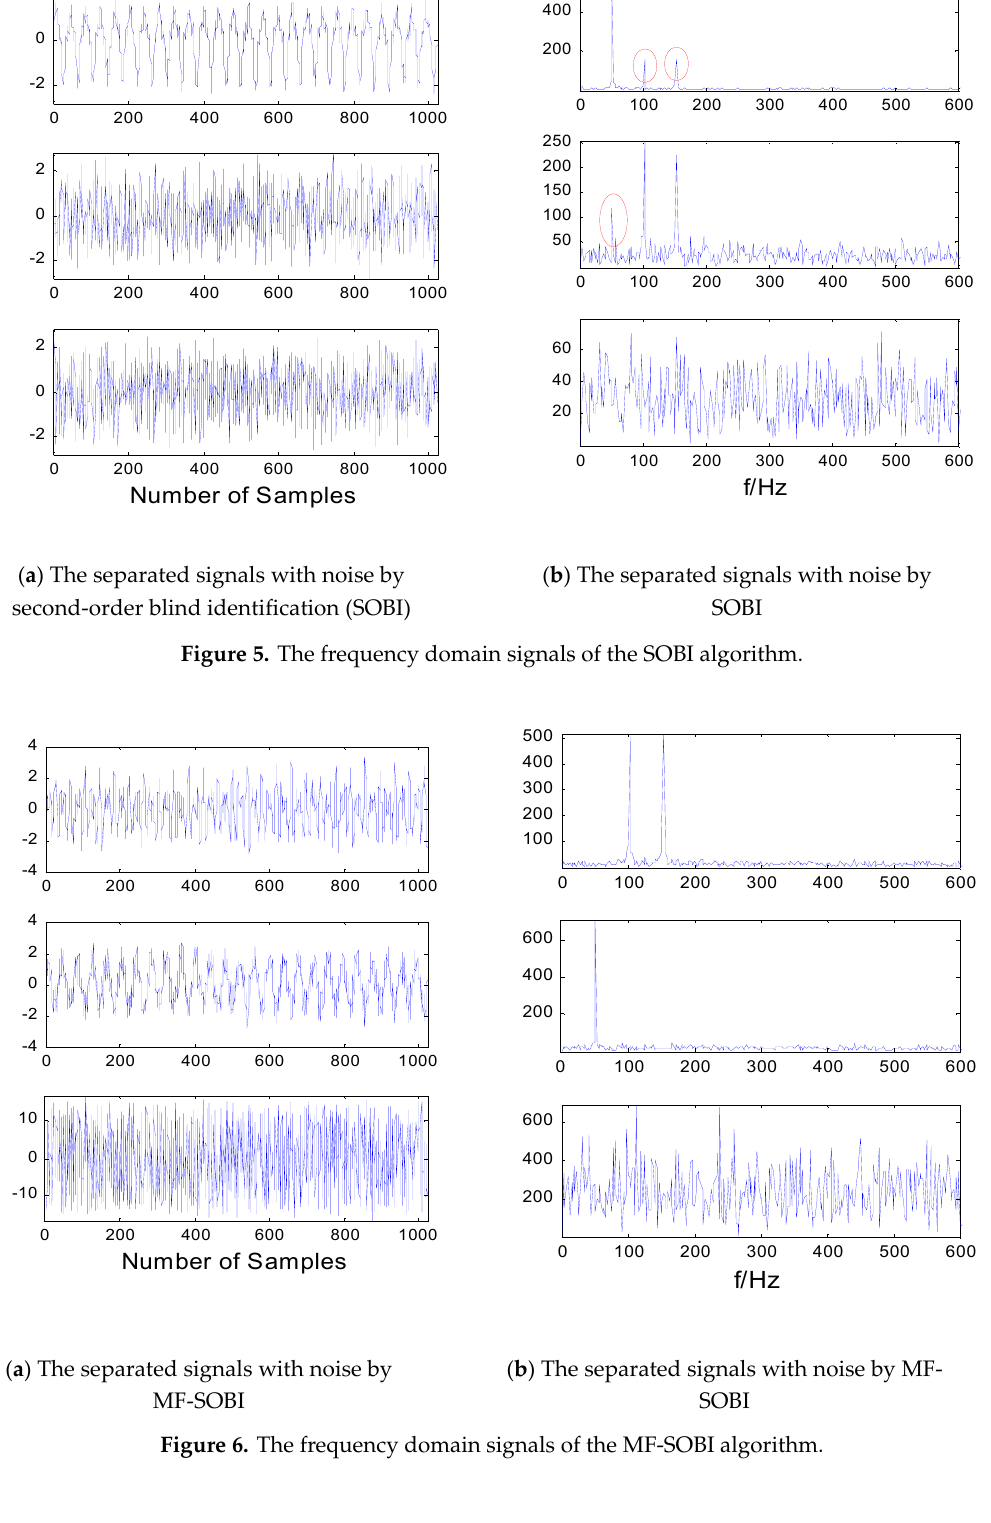
Figure 6. The frequency domain signals of the MF-SOBI algorithm.